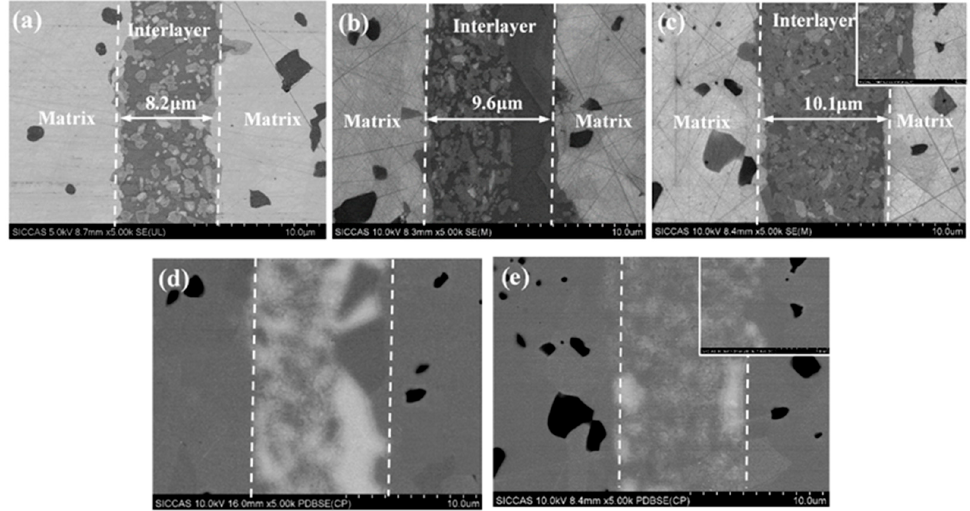
Figure 7. Microstructure and EDS of the joint with different solid loading: ( a ) 13%; ( b ) 19%; ( c ) 26; ( d ) the PDBSE of ( b ); ( e ) the PDBSE of ( c ).